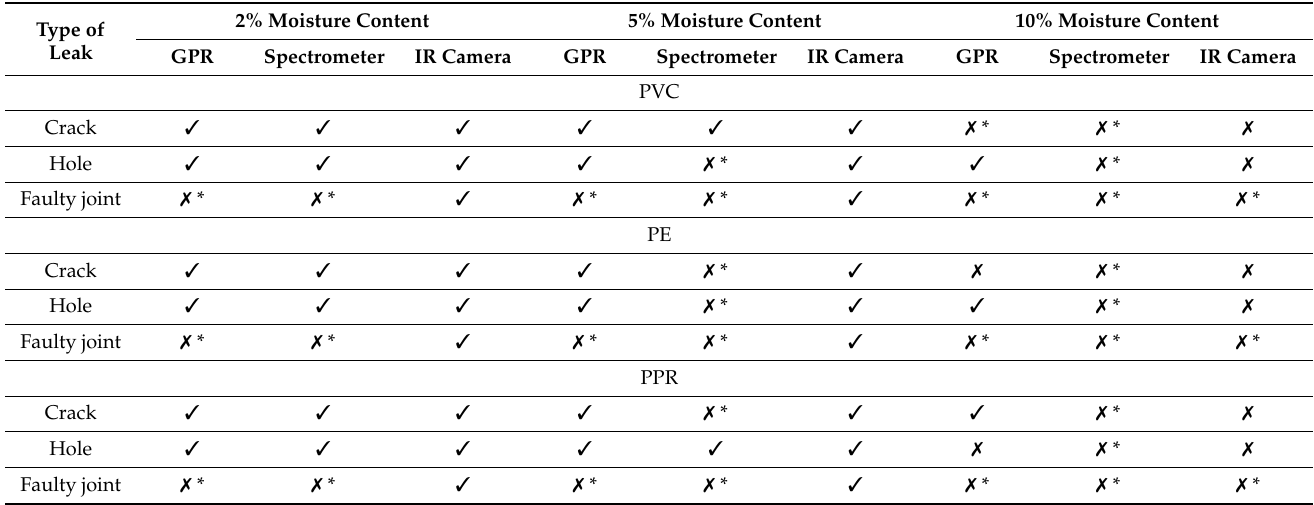
Table 7. Summary of leak detection potential of NDTs.